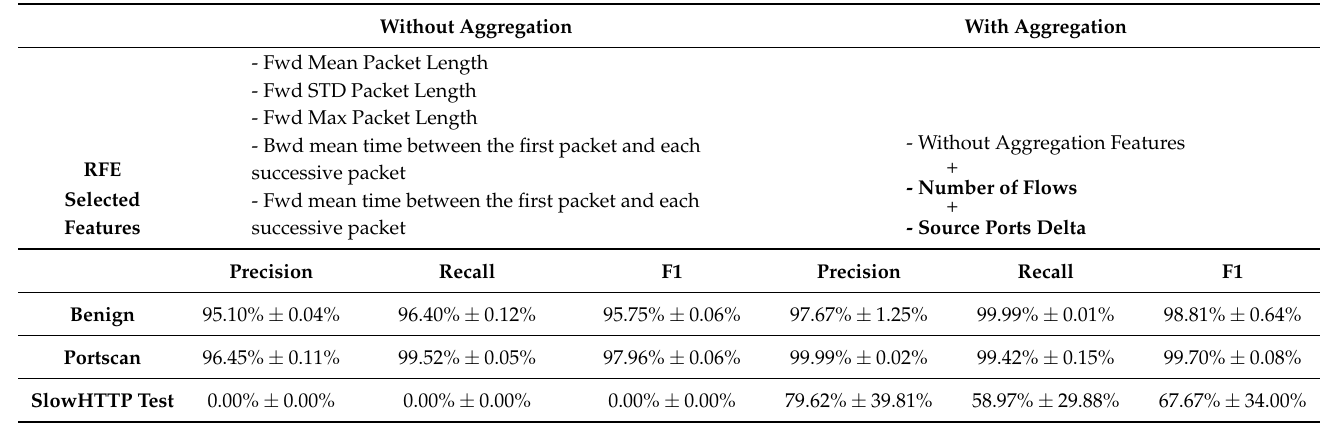
Table 9. Benign vs. PortScan vs. SlowHTTPTest classification (5-fold cross validation). Without Aggregation With